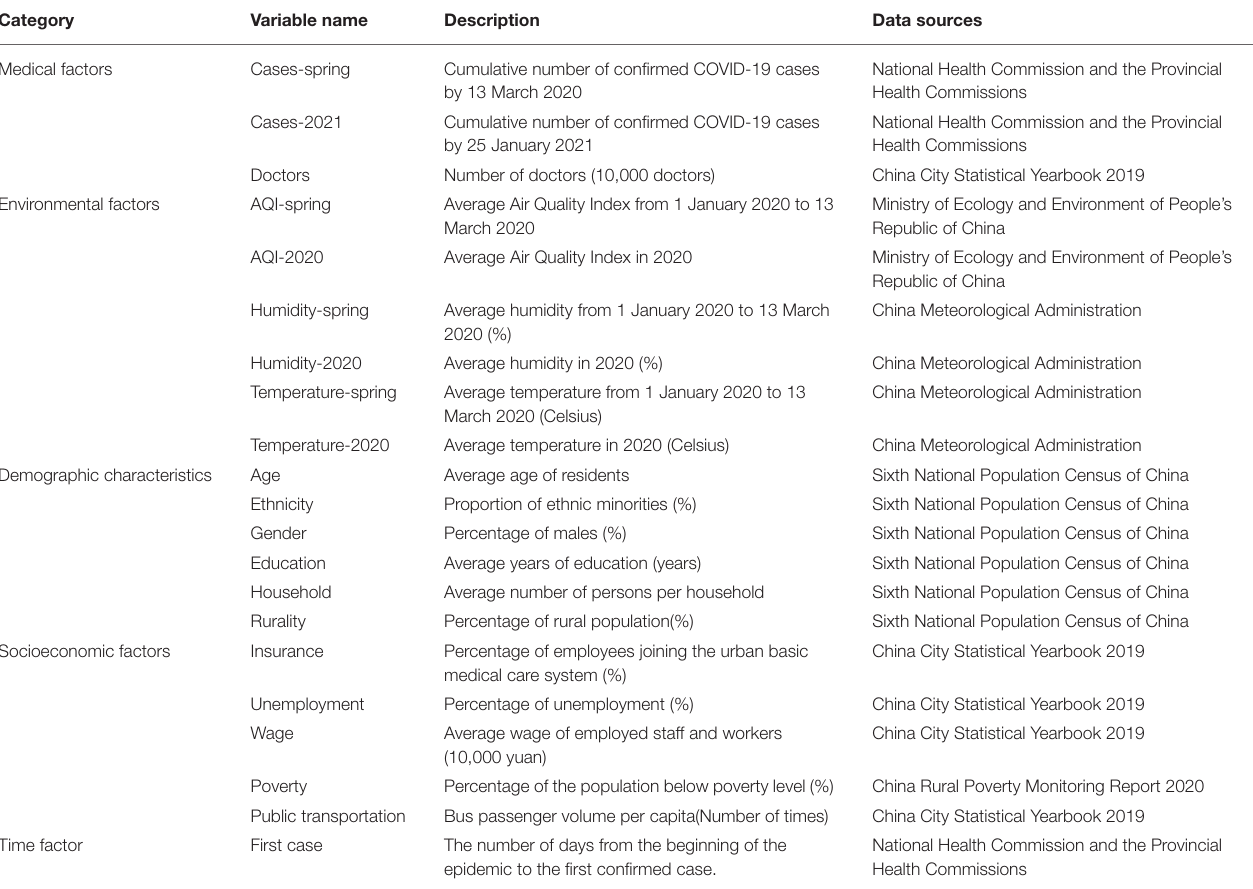
TABLE 1 | Description of explanatory